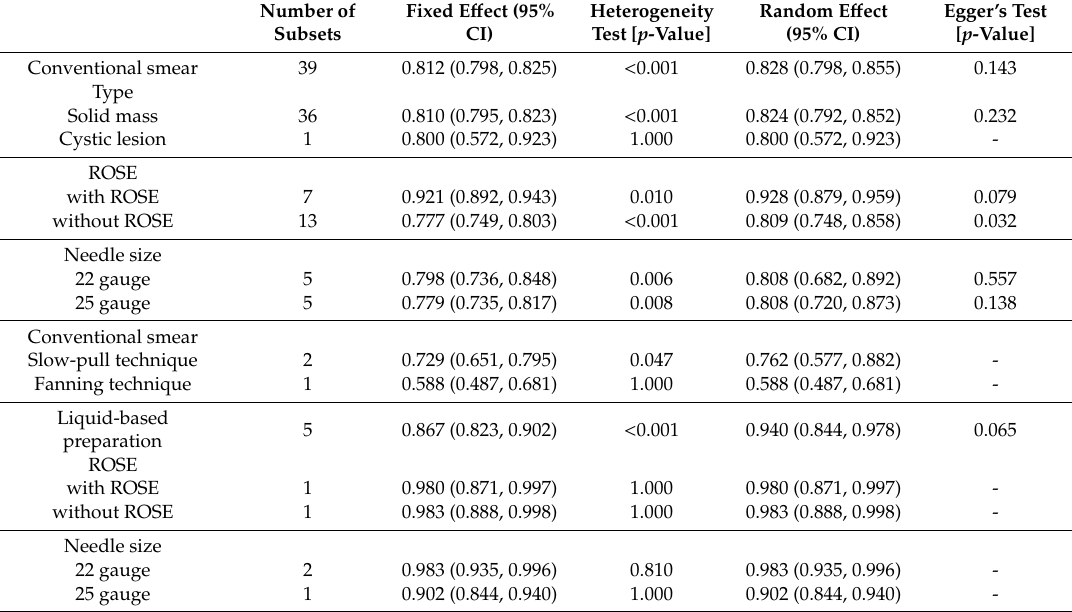
Table 2. Diagnostic accuracy in endoscopic ultrasonography-guided fine-needle aspiration according to the cytologic preparation.